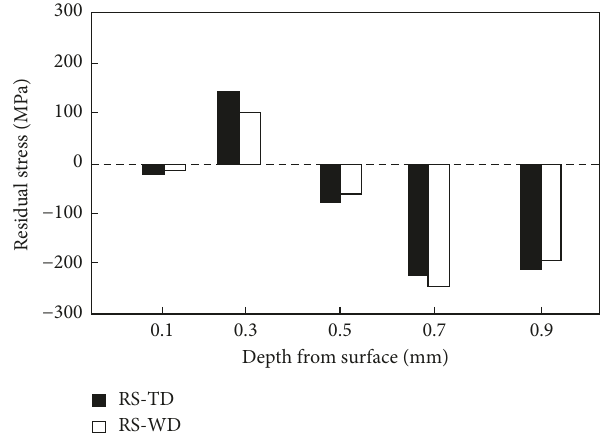
Figure 7: Residual stress distribution of the retreating side.